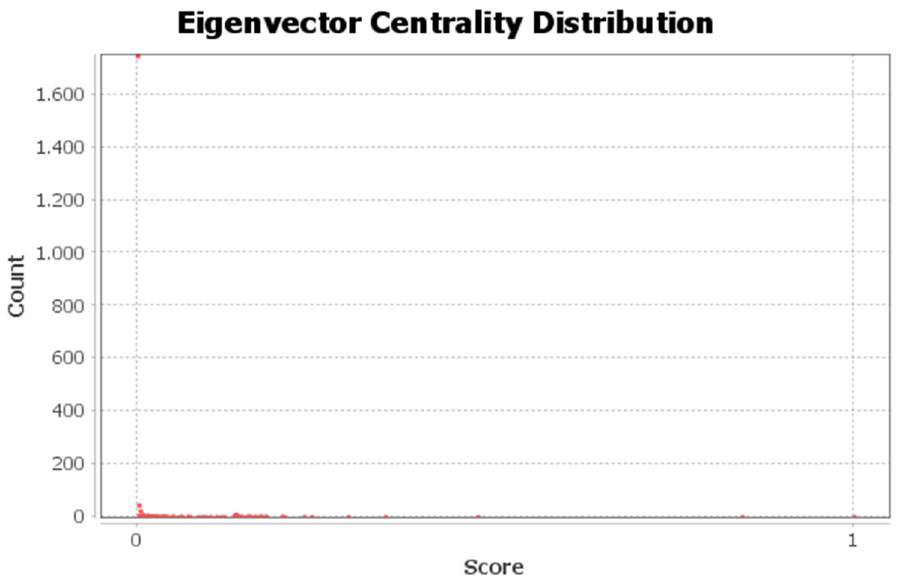
Figure A6. Community size distribution.